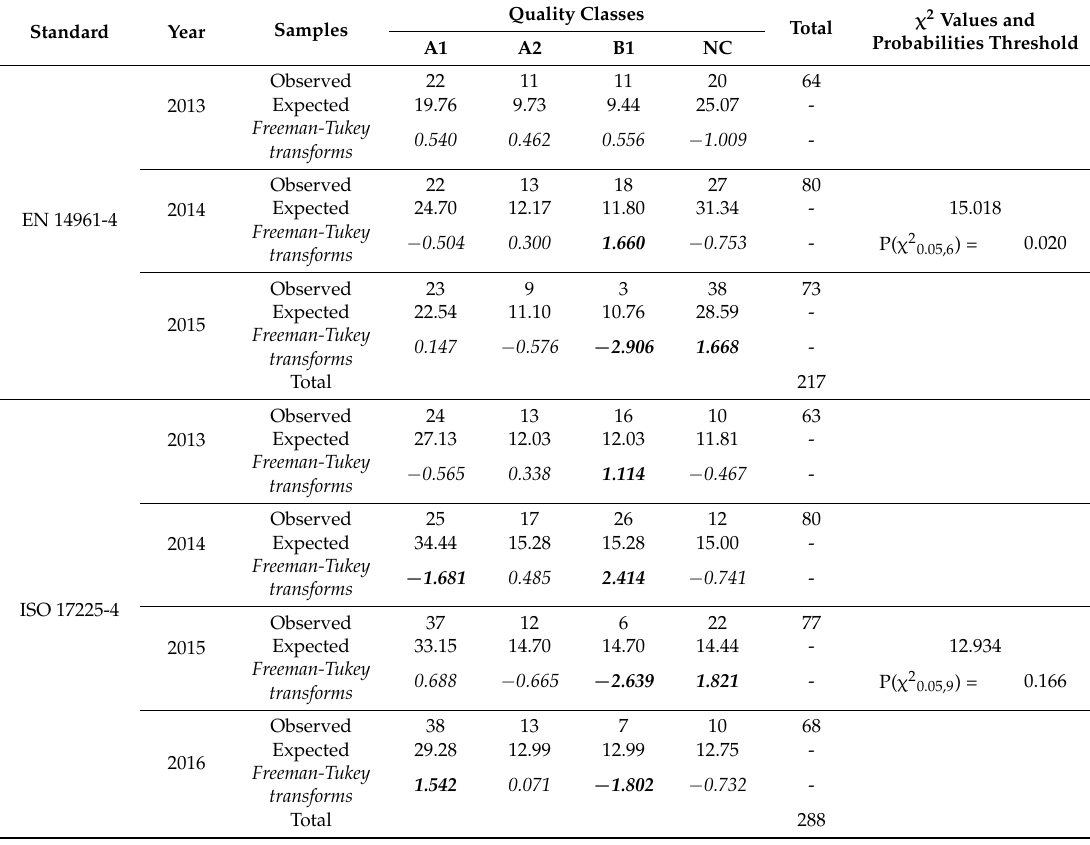
Table 5. Differences between observed and expected quality of wood chips over the years and according to the standards ( χ 2 = Chi square; P= probability). Bold values, in the Freeman-Tuckey transforms, represent comparisons (between observed and expected) significantly above/below the χ 2 probabilities